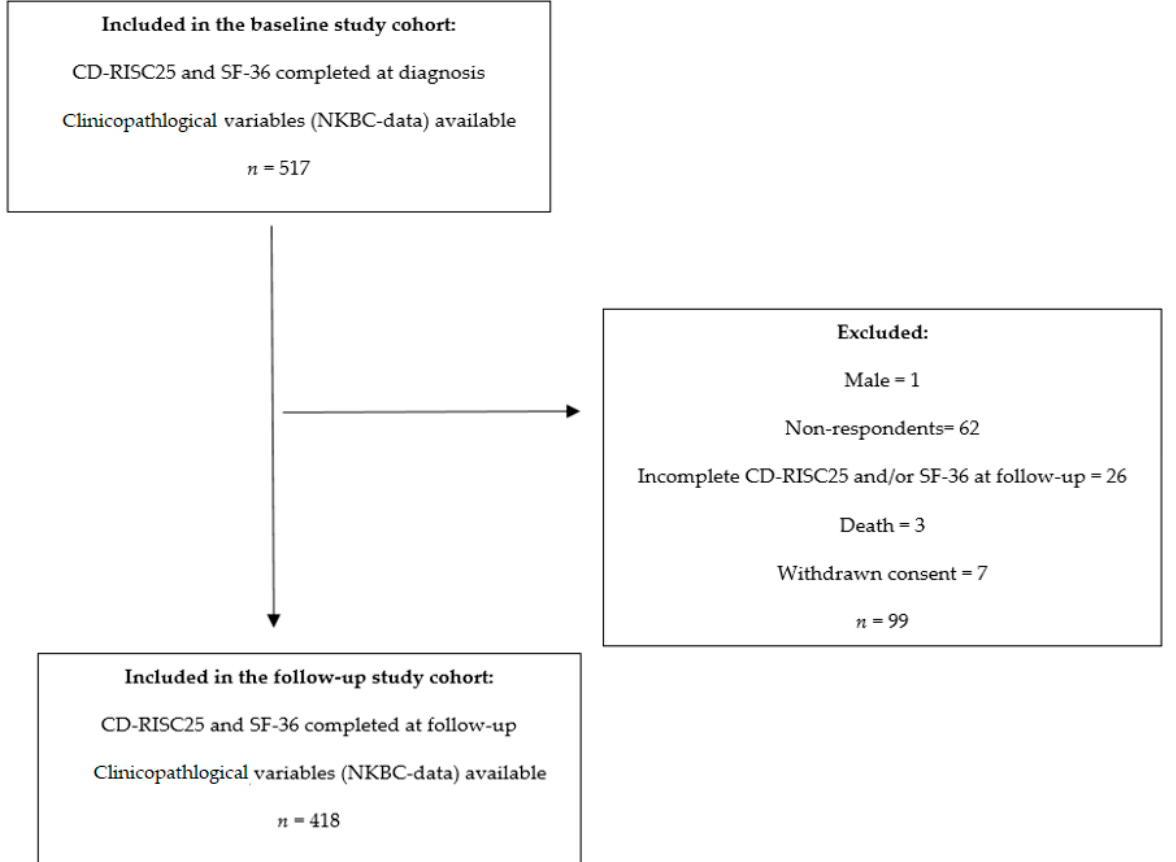
Figure 1. Flow chart of the study cohort. Abbreviations: CD-RISC25, Connor-Davidson Resilience Scale 25; SF-36, Short Form Health Survey; NKBC, Swedish National Quality Register for Breast Cancer.